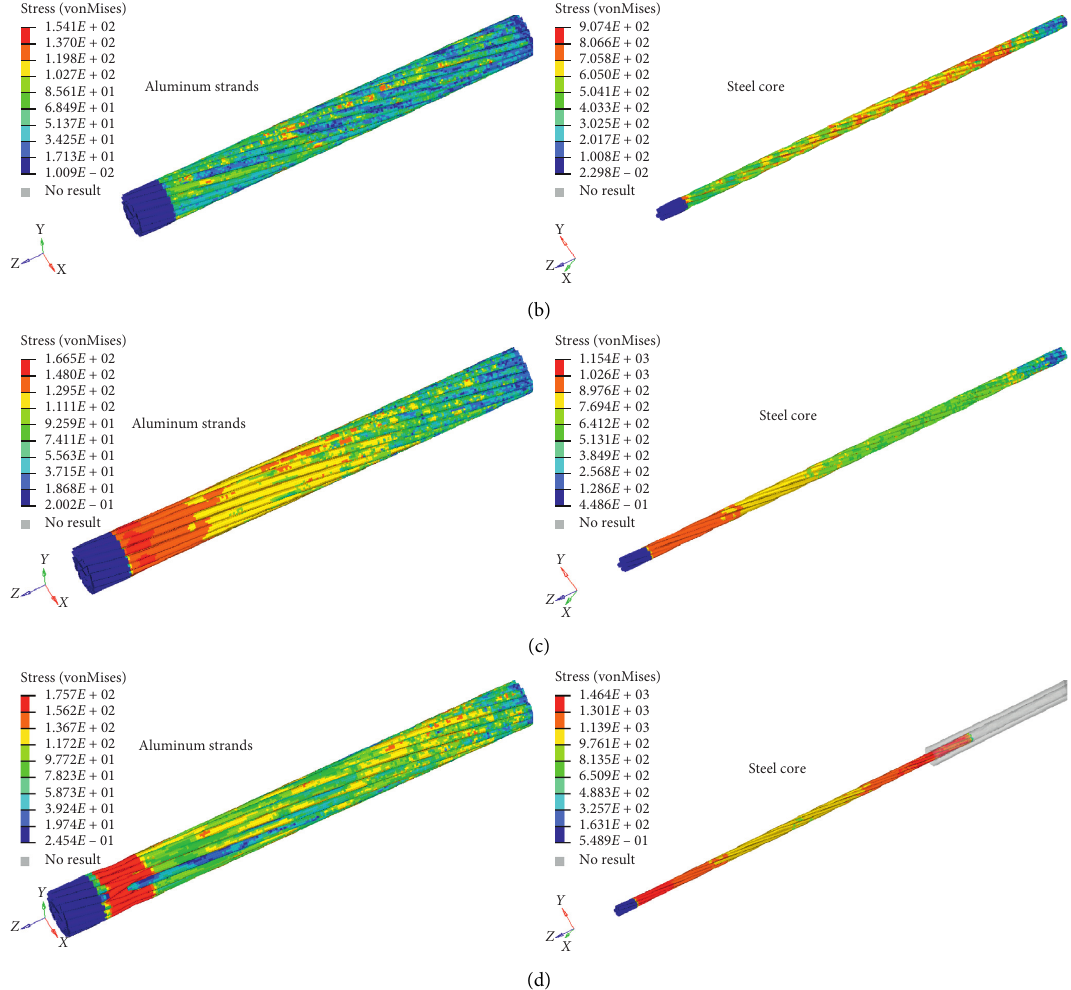
Figure 21: Stress in the aluminum strand and steel core under different tensile loadings: (a) 25% RTS; (b) 50% RTS; (c) 95% RTS; (d) ultimate load.